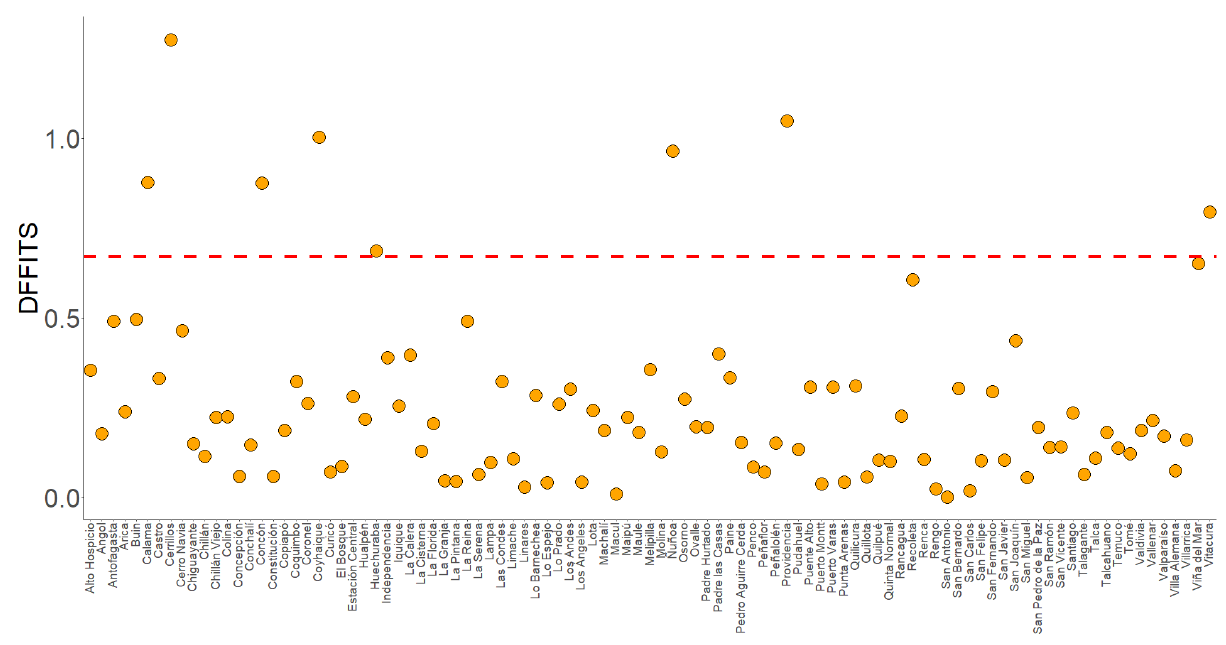
Figure 10. Influential Points considering Discrepancy and Leverage values.